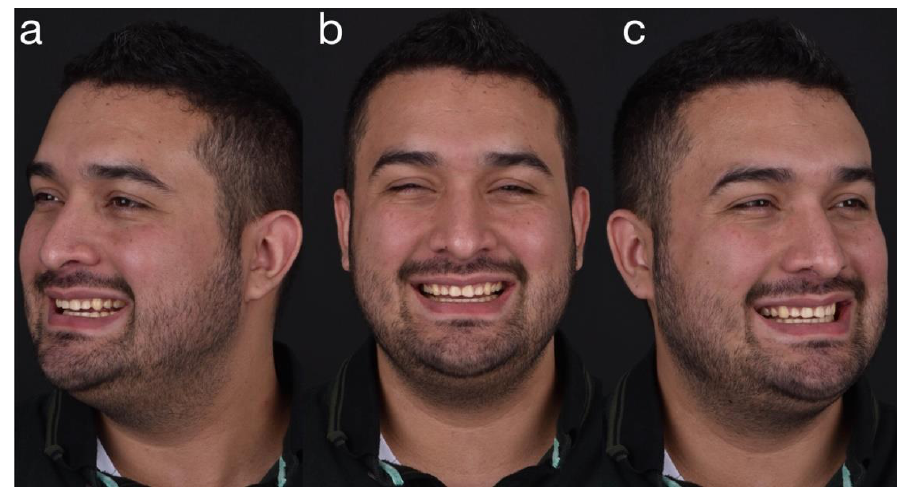
Figure 1. Extraoral facial smiling pictures ( a ) left, ( b ) frontal, ( c ) right.